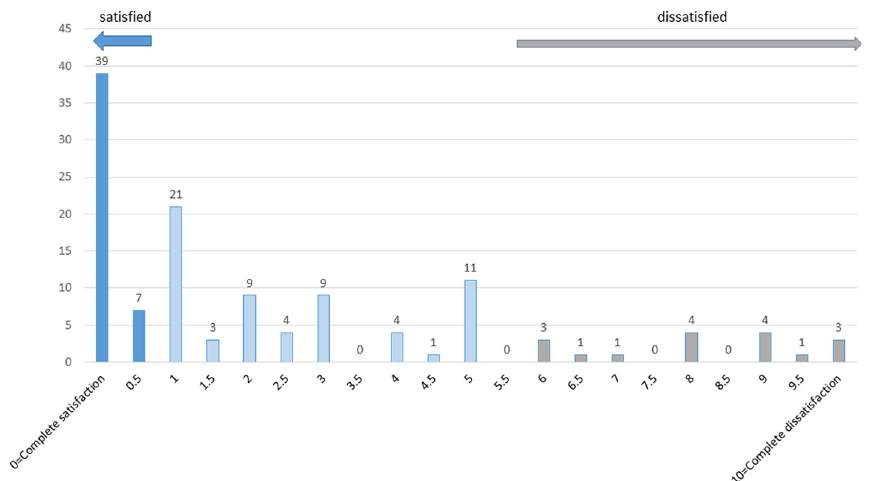
Fig 2. Distribution of patients’ satisfaction with bronchoscopy.